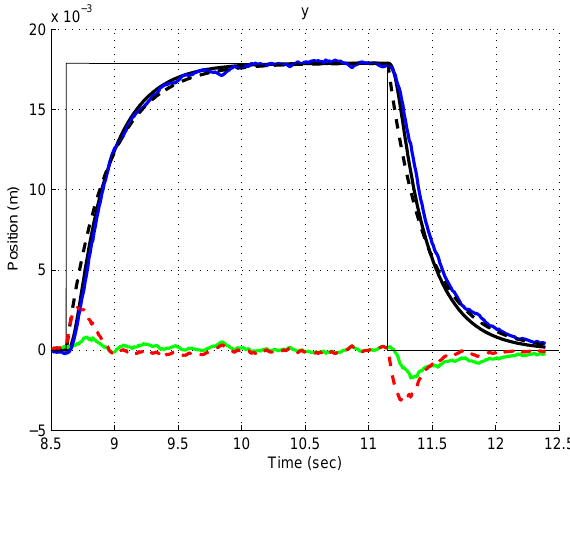
Figure 3: Experimental and simulated results with two different valve models. Blue: measurements, Black: second order model, Green: error second order model, Dashed: proportional model, Red: error proportional model.